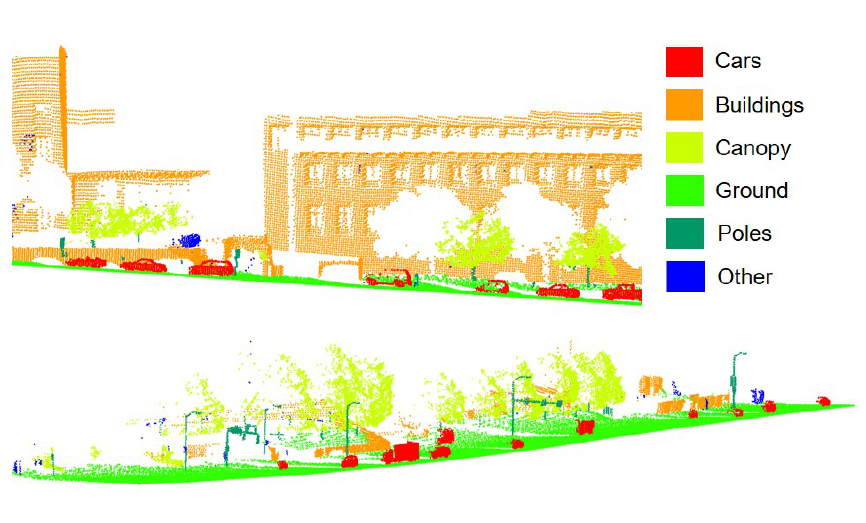
Figure 7. Oakland MLS point cloud. The classes to be extracted have been represented in differ- ent colors.